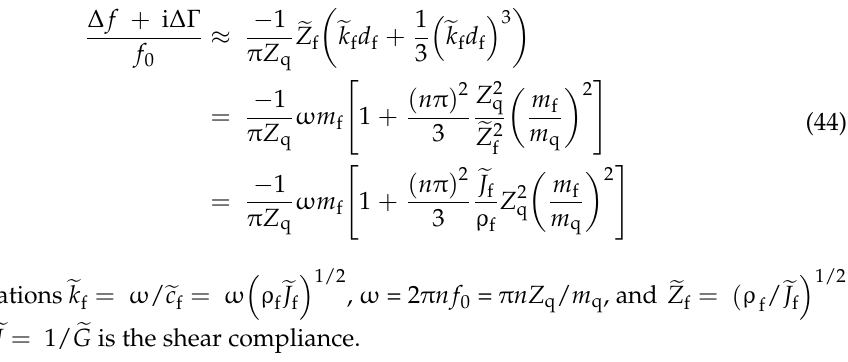
The relations (cid:101) k f = ω / (cid:101) c f = ω were used. (cid:101) J = 1/ (cid:101) G is the shear